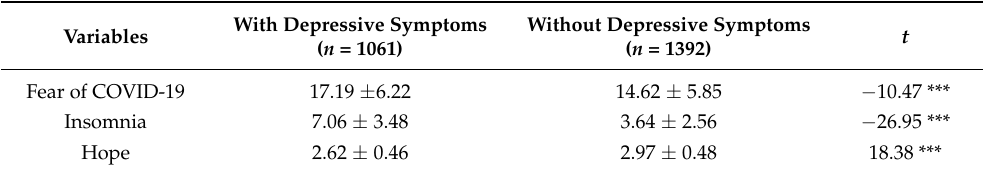
Table 1. Results of t -test of concerned variables between the groups with and without depressive symptoms.